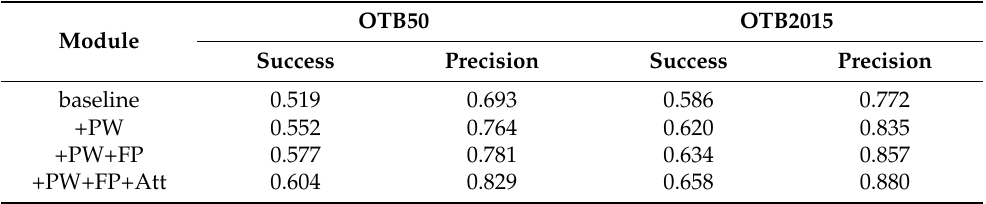
Table 1. Ablation Study of SiamFP on OTB Benchmarks. PW denotes Optical flow Estimated Network. FP denotes Feature Pyramid. Att denotes Dual-attention